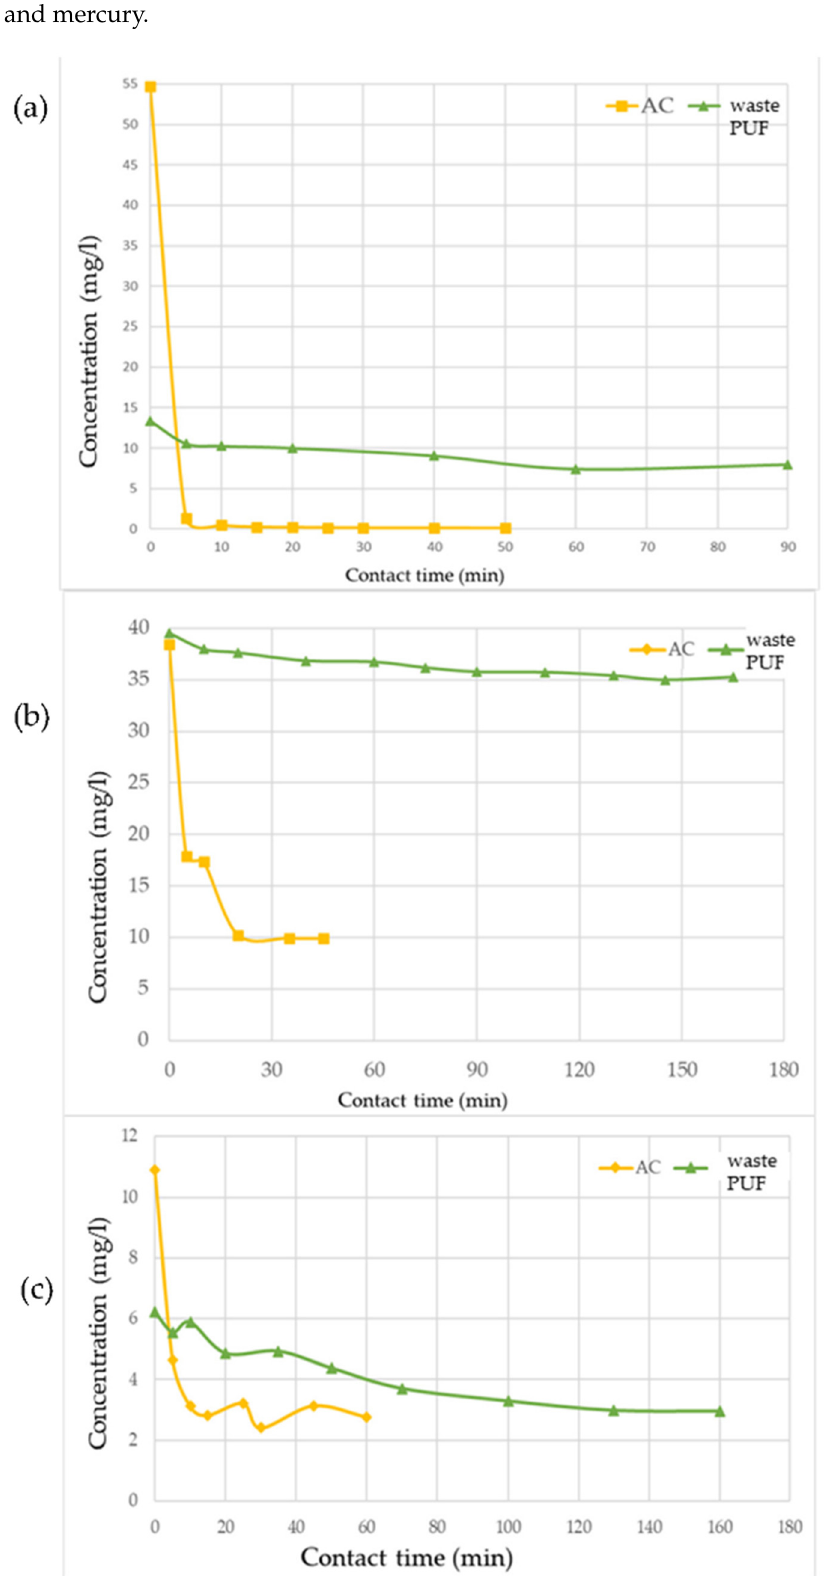
Figure 1. Results of the adsorption equilibrium tests performed on waste PUF and AC with ( a ) methylene blue, ( b ) phenol, and ( c ) mercury.